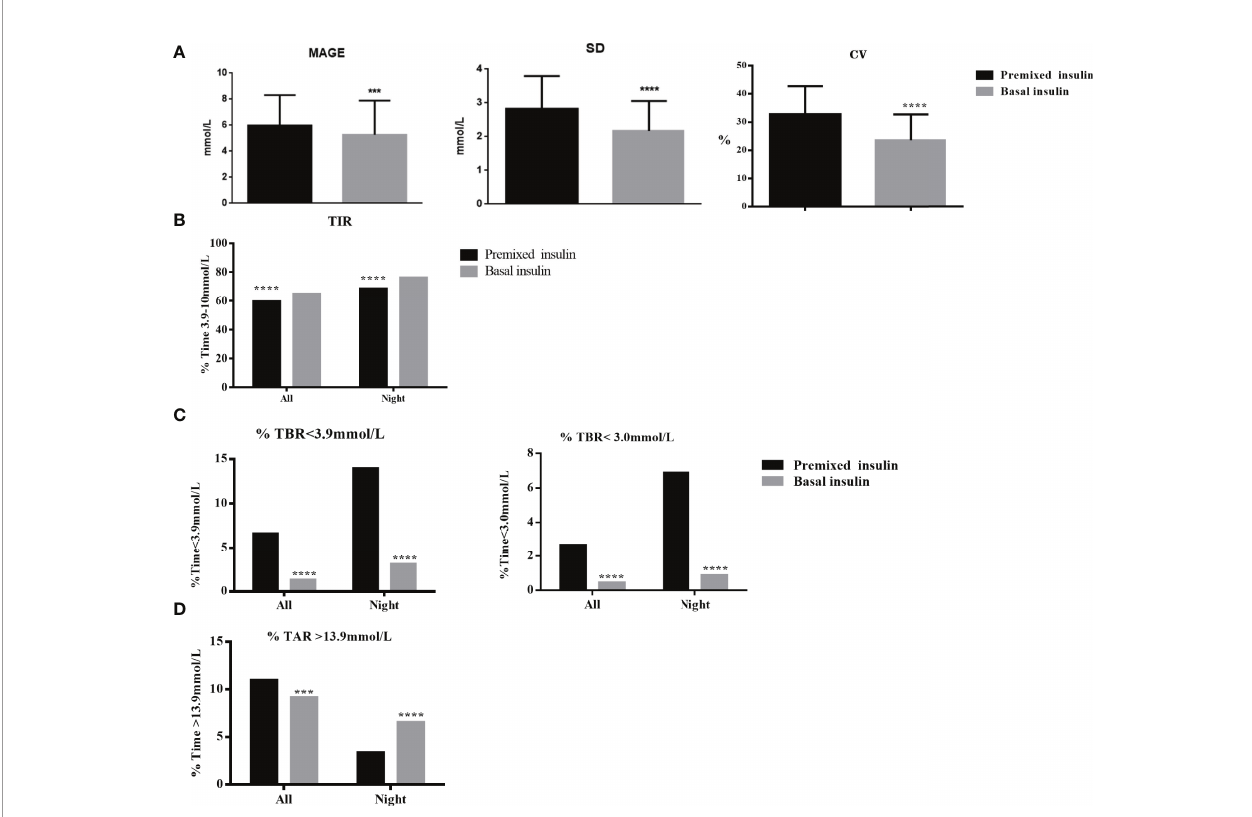
FIGURE 3 | (A) GV (MAGE, SD, CV) of the basal insulin group and the premixed insulin group within the full 24-hrs. (B) Percentage of TIR (3.0~10 mmol/L) of the basal insulin group and the premixed insulin group within the full 24-hrs and nighttime (00:00 – 05:59) periods. (C) TBR (<3.9 and <3.0 mmol/L) of the basal insulin group and the premixed insulin group within the full 24-hrs and nighttime (00:00 – 05:59) periods. (D) TAR (>13.9 mmol/L) of the basal insulin group and the premixed insulin group within the full 24-hrs and nighttime (00:00 – 05:59) periods. ***p < 0.001, ****p < 0.0001.